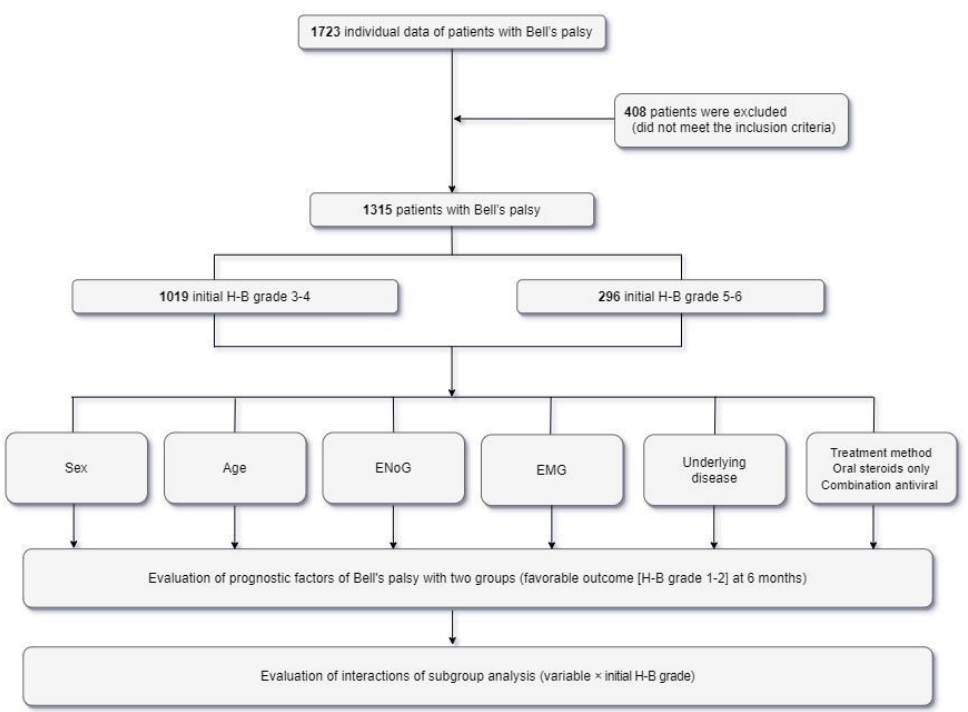
Figure 1. Flow diagram of the study population. H-B grade = House–Brackmann grade, ENoG = electroneuronography, EMG = electromyography. Demographic and clinical characteristics were obtained from patient records, includ- ing age, gender, prior underlying conditions (e.g., diabetes mellitus, controlled hyperten- sion), and the results of electrophysiological tests. Patients were evaluated by electroneu- rography (ENoG) 4 or 5 days after the onset of symptoms, and all patients underwent needle electromyography (EMG) 2 weeks after the onset of facial paralysis. Results were reported as the percentage of the maximal amplitude on the affected side divided by the maximal amplitude on the normal side. A poor ENoG result was defined as a >90% loss in amplitude, whereas a good result was defined as a ≤ 90% loss [13]. The presence or ab- sence of a blink reflex and needle EMG results were analyzed simultaneously, with out-